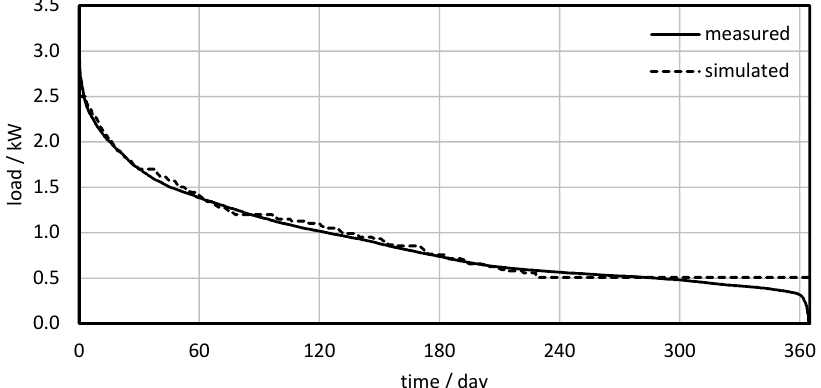
Figure 8. Comparison of the measured and simulated loads.